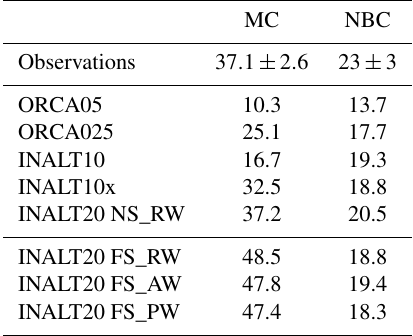
Table 6. Mean (2004–2009) transport (in Sv) through the Mozambique Channel (MOZ) and correlations between observed and modelled transport time series based on monthly averages including | subtracting the seasonal cycle. Correlations, significant at 95% confidence level, are given in bold.